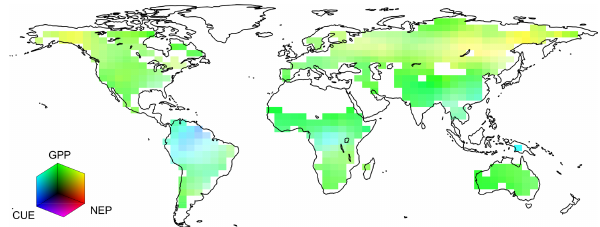
Figure 5. RGB map of relative contributions to R h uncertainty in each of the input datasets, NEP (red), CUE (blue), and GPP (green). Note that a yellow color signifies similarly sized uncertainties for GPP and NEP, which are much larger than the uncertainty for